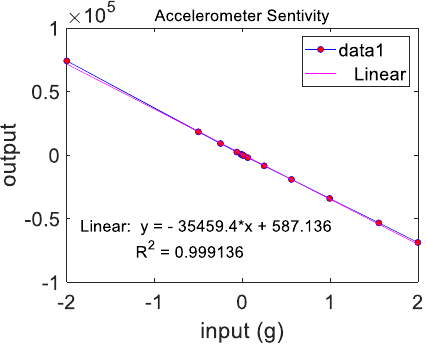
Figure 9. The test result of the scale factor. The accelerometer output was continuously sampled at 120 Hz for more than two hours when the input was zero, and the result is shown in Figure 10. The corresponding RMS noise was about 163.8 μg, the corresponding tilt noise was 0.0094°, and the noise densi ty near 10 Hz was about 1.2 μg/√ Hz, the test results are shown in Figure 10.